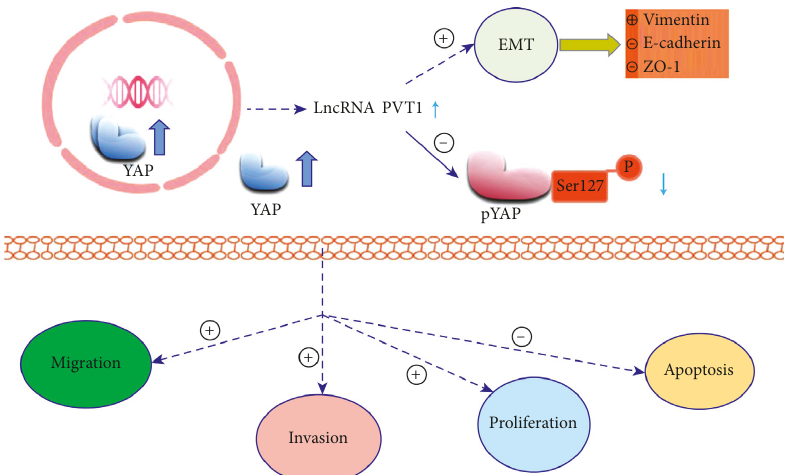
Figure 5: The relationship among PVT1, YAP, and EMT in GC. PVT1 and YAP were both upregulated in GC tissues. In GC, PVT1 promotes the expression of YAP, inhibits the expression of p-YAP, promotes tumor cell proliferation, tumor cell migration, and invasion, and inhibits cell apoptosis. The increased expression of PVT1 promotes